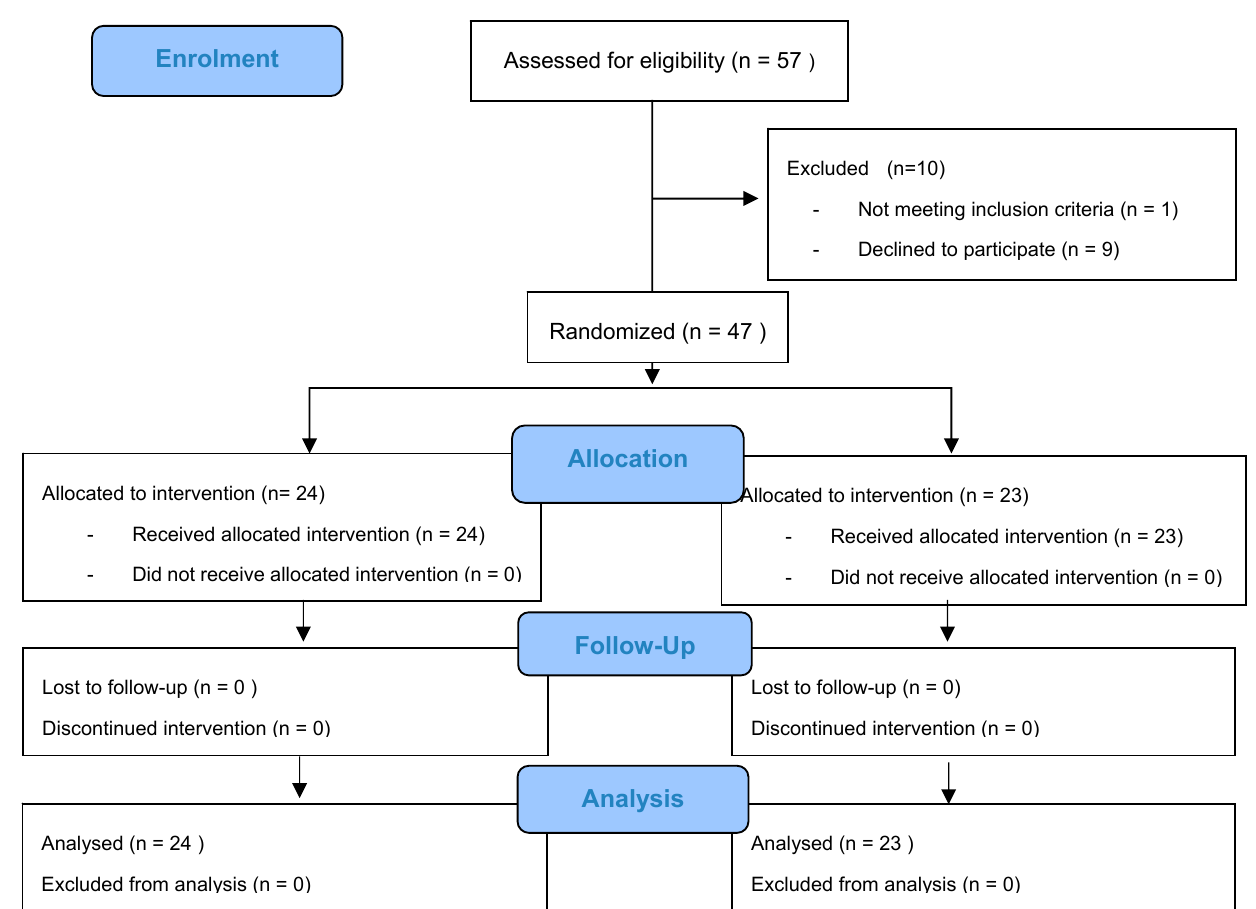
Figure 1. The flowchart of patient recruitment.